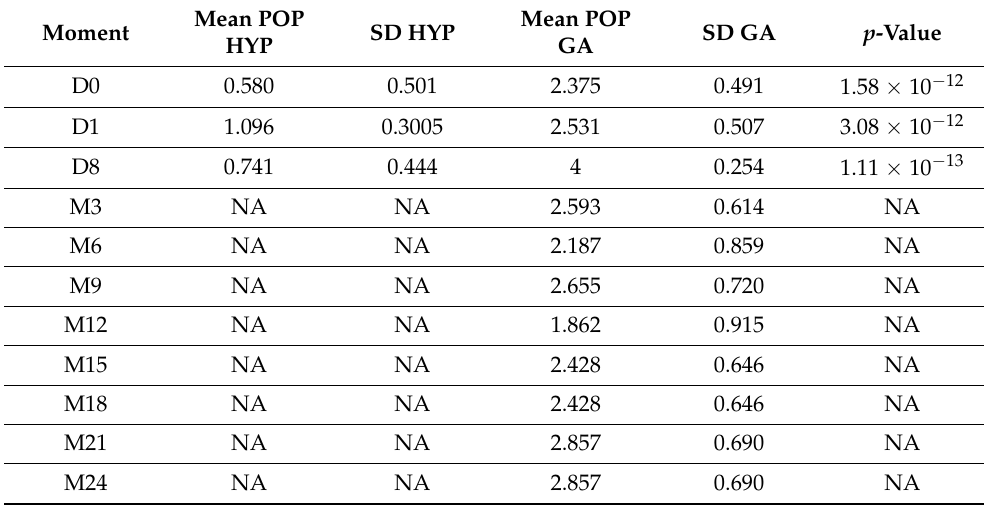
Table 4. Average pain ratings at the different measurement